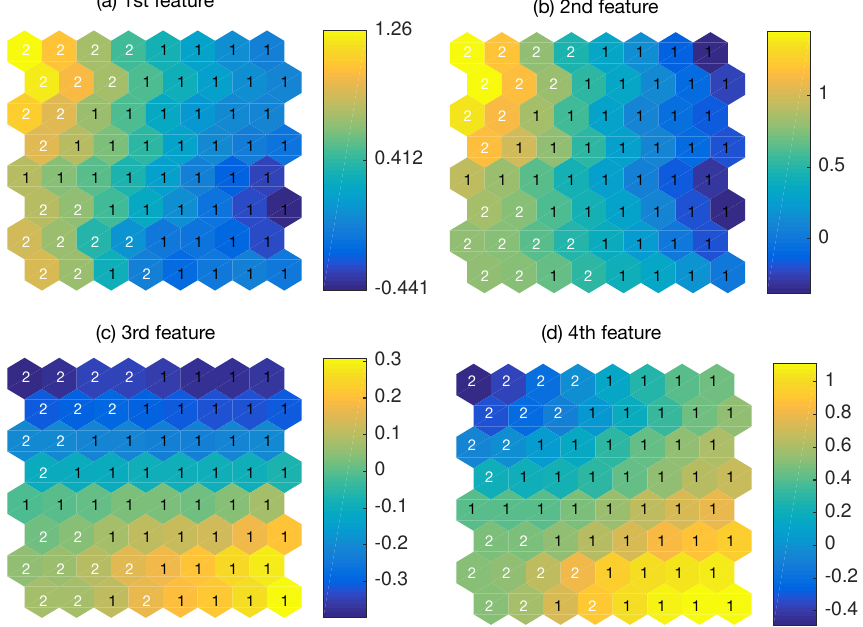
Figure 6. Feature weights visualization.